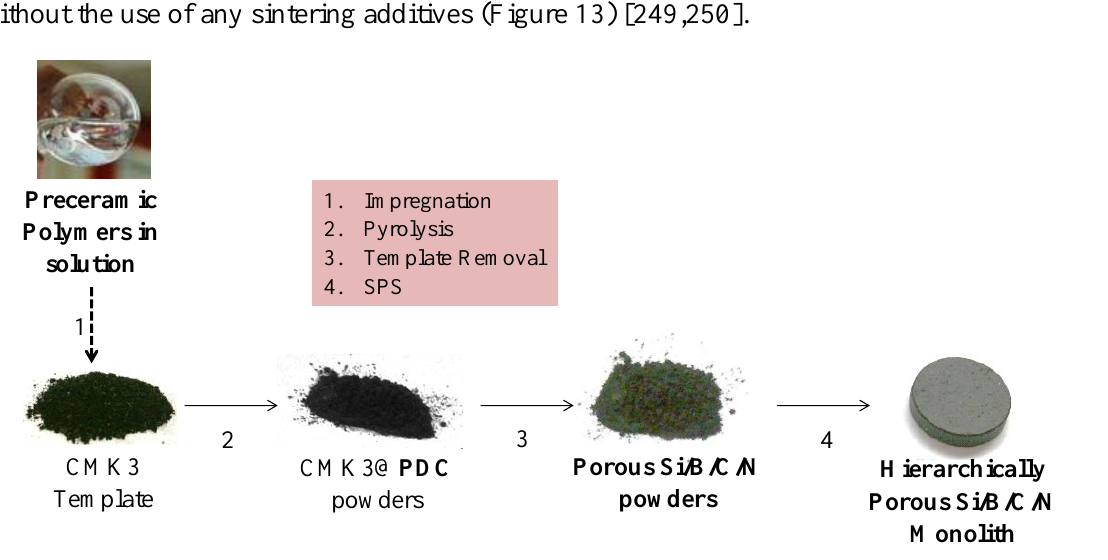
Figure 13. Overall synthetic path employed to generate hierarchically porous Si/B/C/N monoliths coupling the PDCs route with nanocasting and spark plasma sintering (SPS)